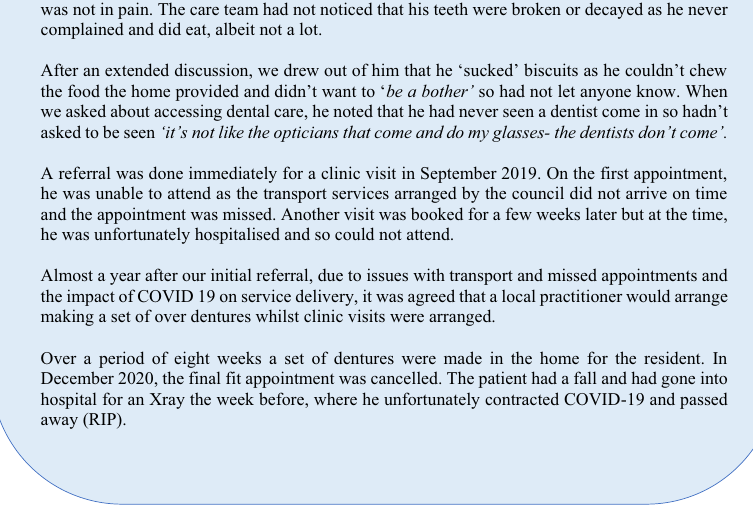
Fig. 2 Clinical case study exemplifying the systematic challages faced in accessing